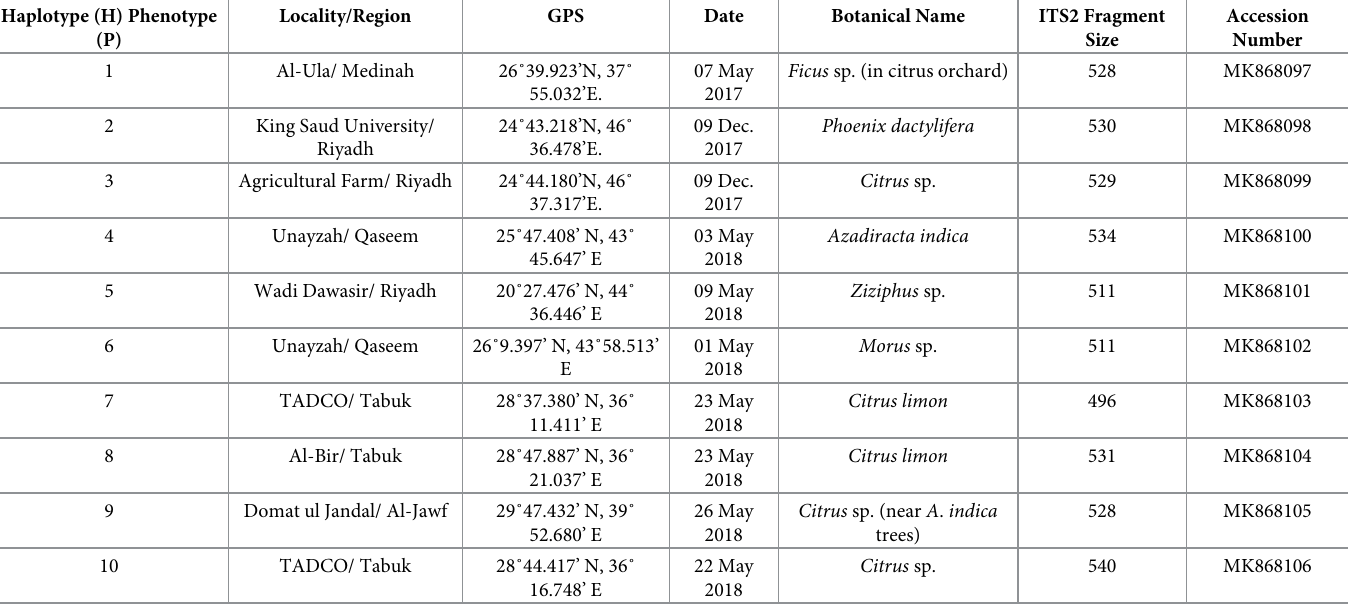
Table 1. Geographical distribution and host plant information of Saudi E . orientalis